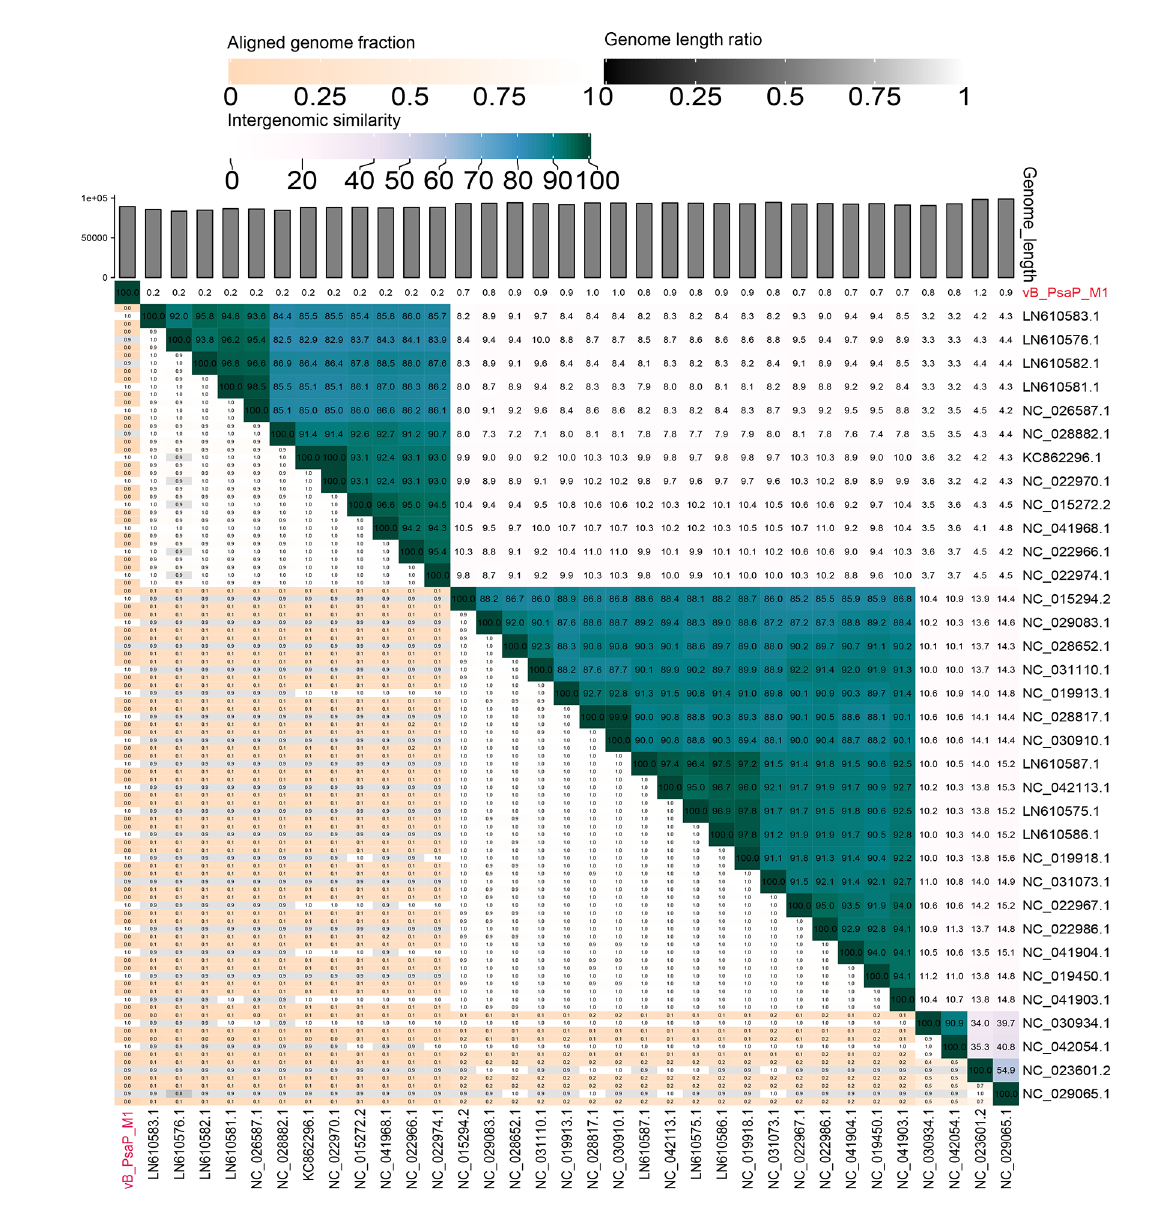
FIGURE 5 Shared gene heat map of vB_PsaP_M1 and vB_PsaP_M1 like virus in rectangular phylogenetic tree. In the right half, color coding allows rapid visualization of phage genome clustering based on intergenic similarity: the closer the relationship between genomes, the darker the color. These numbers represent the similarity values of each genome pair. In the left half, the three indicator values of each genome pair are expressed in order from top to bottom: aligned partial genome 1 (for the genome found in this row), genome length ratio (for two genomes in this pair), and aligned partial genome 2 (for the genome found in this column). Darker colors emphasize lower values, indicating that there is only a small number of genome aligned genome pairs (orange to white gradient), or there is a large difference in the length of the two genomes (black to white gradient). As the distance between phages increases, the aligned genomic fragments are expected to